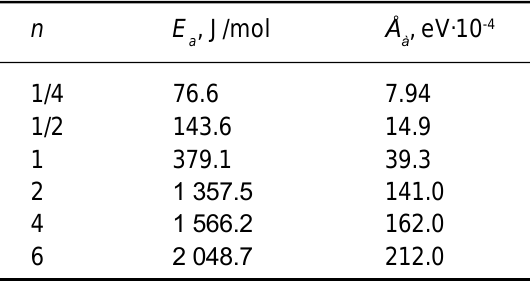
Table 2. The values of E Ti Ni Cu 50 25 25